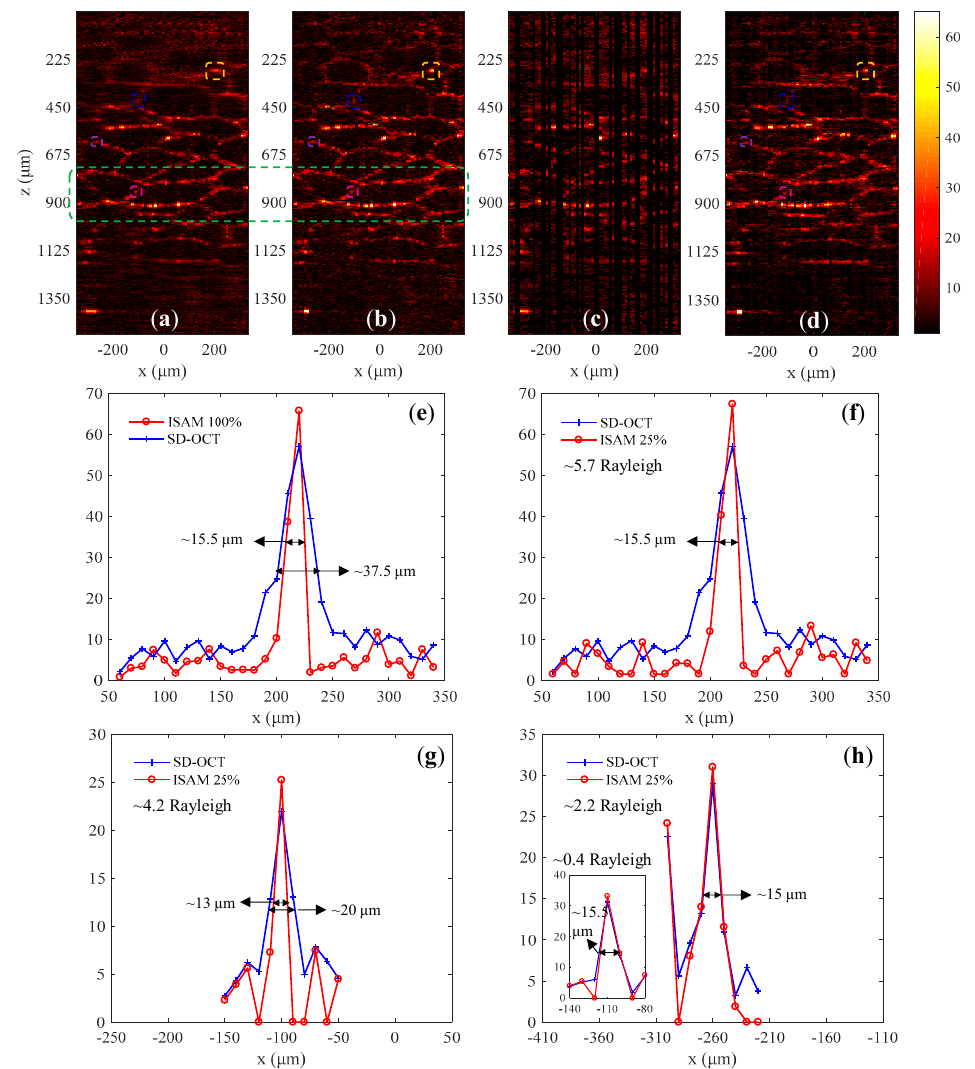
Figure 5. Experiment results of the acinar cells of an orange. The images in ( a ) and ( b ) are results of SD-OCT and ISAM obtained by complete spectral data, respectively; ( c ) shows the image in which the selected A-scans were reconstructed, and ( d ) shows the reconstructed 2D image using 50% × 50% data. The depth range within the green dashed box in ( a ) and ( b ) is the theoretical range of depth of focus (DOF). ( e ) Lateral distribution of the structures within the yellow dashed boxes in ( a ) and ( b ); ( f ) lateral distribution of the structures within the yellow dashed boxes in ( a ) and ( d ); ( g ) and ( h ) lateral distribution of the structures within the blue and purple dashed boxes in ( a ) and ( d ).